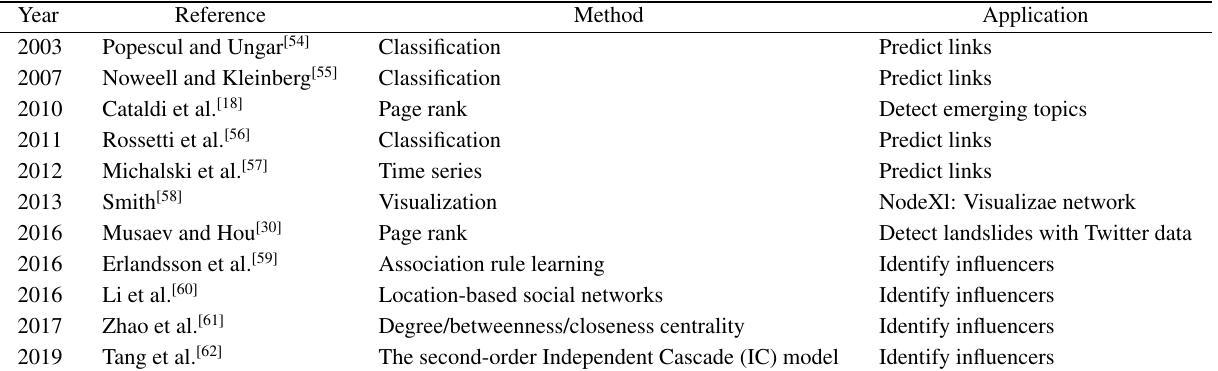
Table 4 Summary of previous works in network